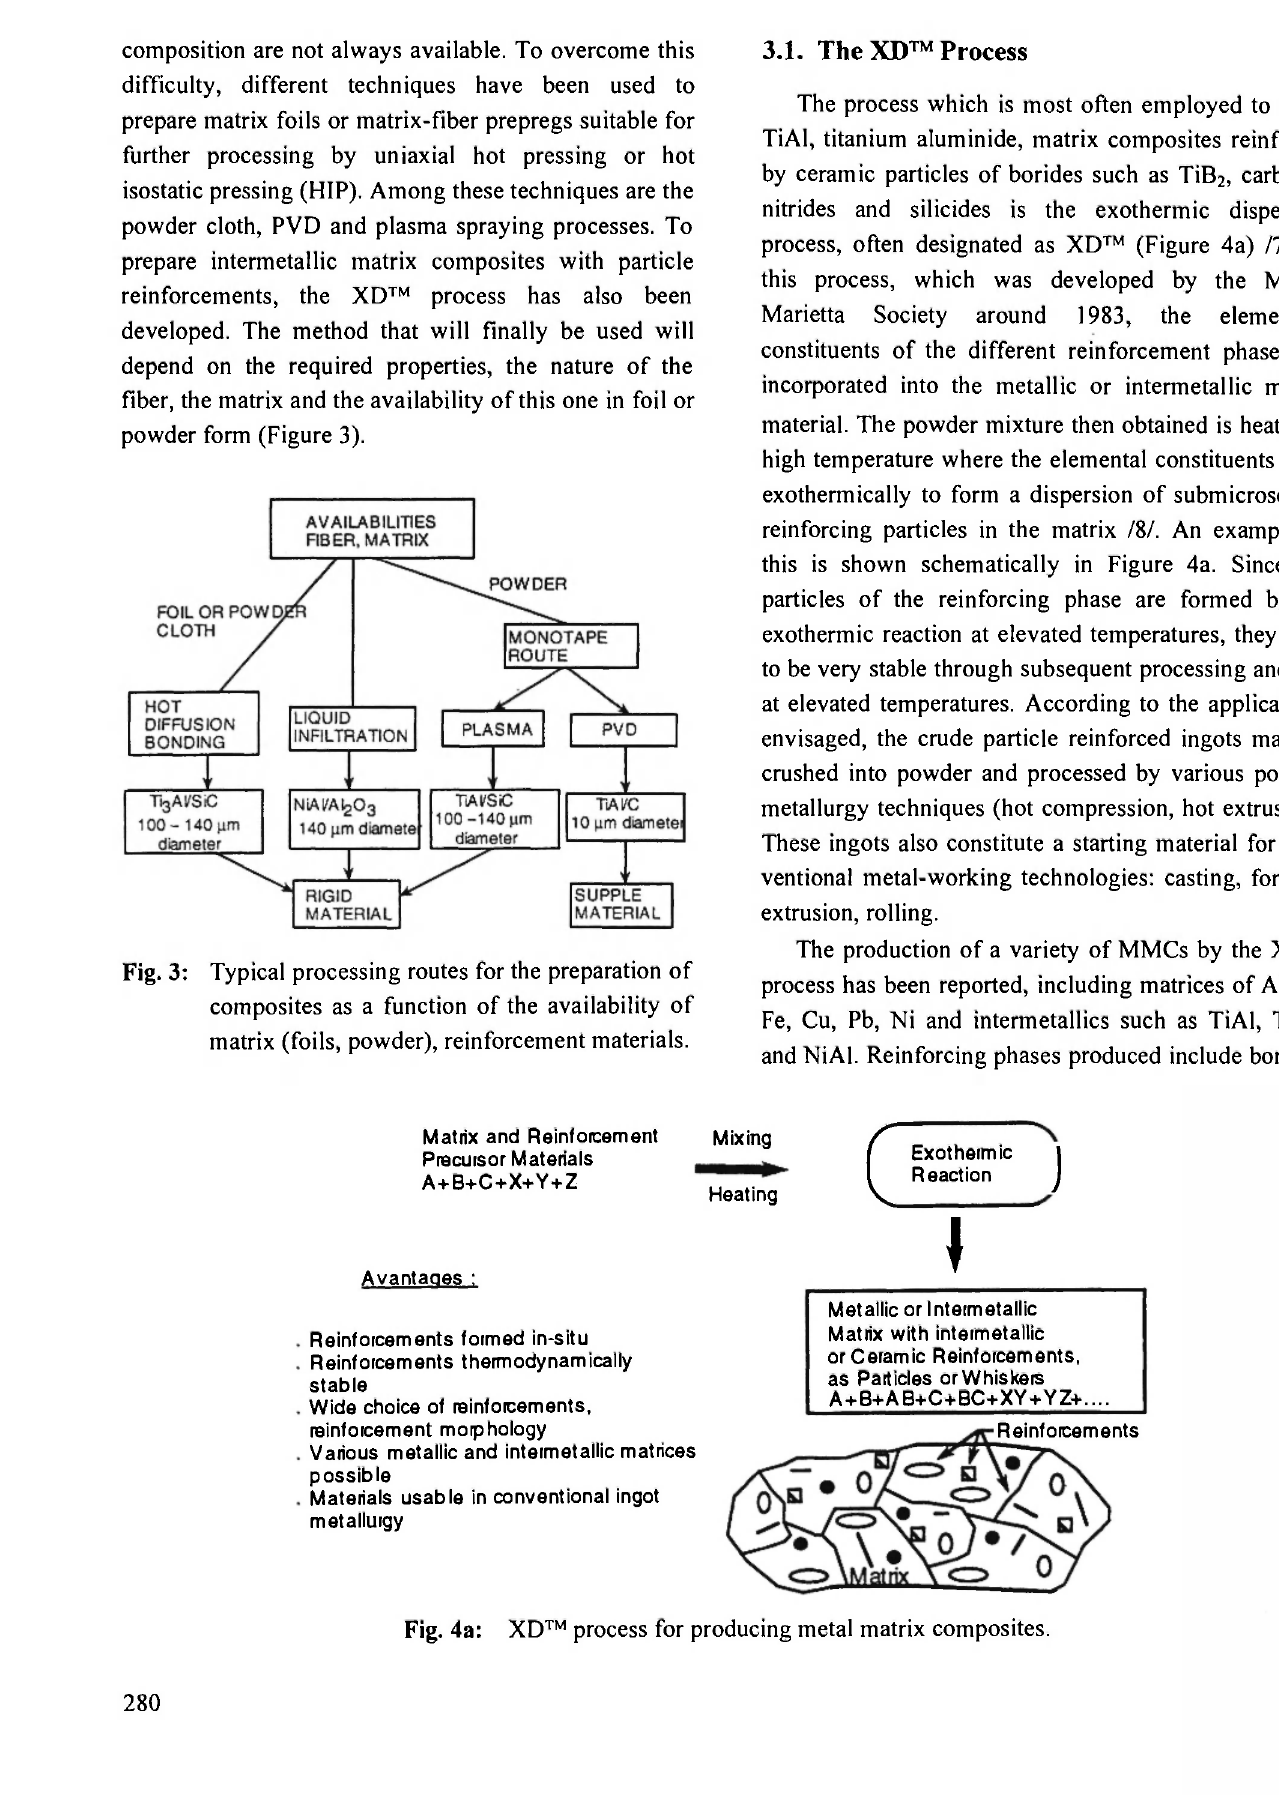
Fig. 4a: XD™ process for producing metal matrix